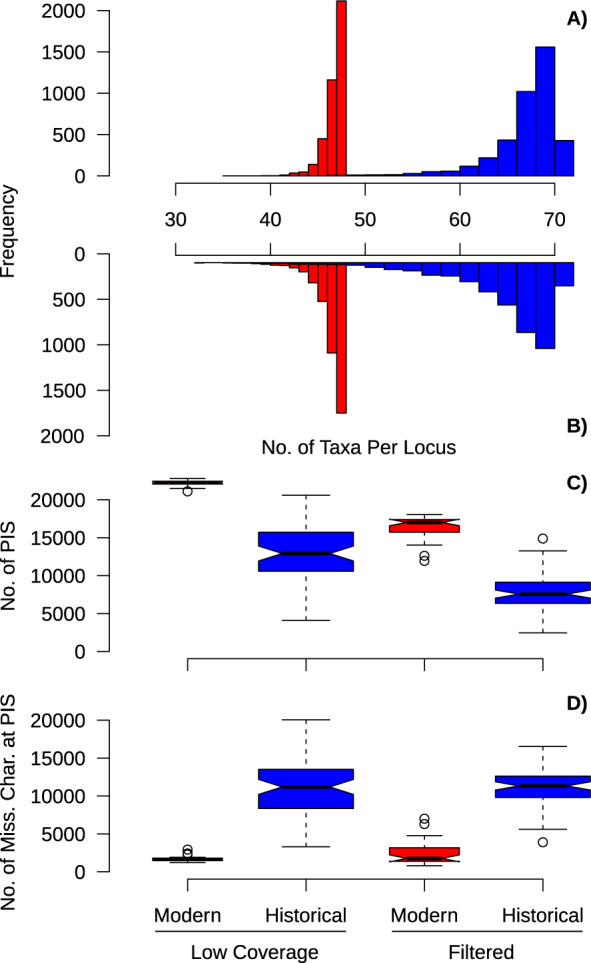
Modern samples have more parsimony informative sites (PIS), less missing data at PIS, and less variation in number of samples among loci. Shown are histograms of the number of samples per locus in the Low Coverage (A) and Filtered (B) alignments. (C, D) Boxplots showing the number of parsimony informative sites (C) and number of missing characters at parsimony informative sites (D) in the ingroup samples. The data are partitioned into the modern versus historical samples, and Low Coverage versus Filtered alignments. In all plots, modern samples are shown in red and historical samples in blue.